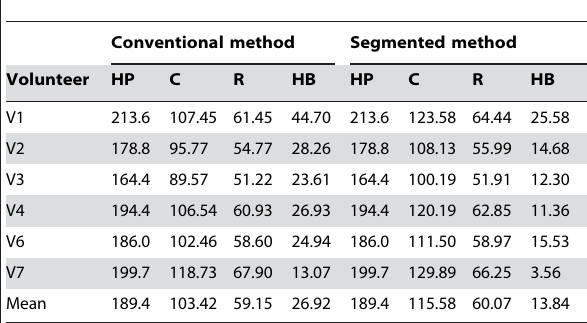
Table 7. Estimates of heat production, convective heat loss, radiant heat loss and heat balance using the conventional method and the segmented method when Ta is 25 u C.